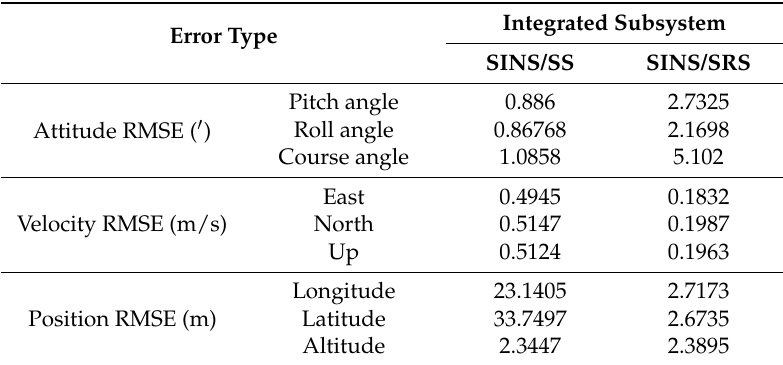
Figure 8. Latitude errors of SINS as well as SINS/SS and SINS/SRS integrated subsystems. Table 3. Errors of SINS/SRS and SINS/SS integrated subsystems.